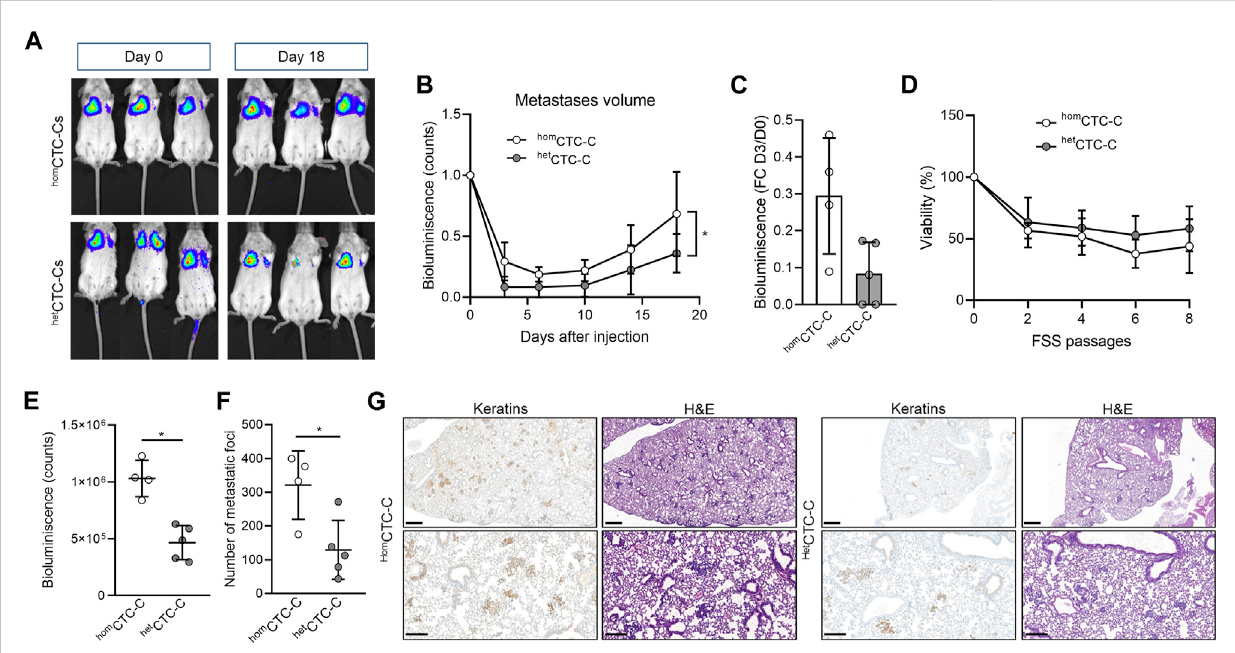
FIGURE 3 Assessing metastatic colonisation ability of hom CTC-C and het CTC-C inthemouse. (A) Representative imagesof thedevelopmentoflung metastatic lesions over time in mice injected into the lateral tail vein with hom CTC-C and het CTC-C assessed by measuring the bioluminescence signal (counts); (B) Bioluminescence signal throughout time emitted by the tumour cells that has colonised the pulmonary tissue (at least n = 4 mice per group); (C) Percentageofdecreaseofthebioluminescencesignalinthelungofmice3daysaftertailveininjectionof hom CTC-Cor het CTC-C; (D) Cellviabilityof hom CTC-Cand het CTC-Csubjectedtodifferentpassagesofhighmagnitude fl uidshearstress(FSS); (E) Quanti fi cationofthebioluminescencesignalinthe lungs at day 18; (F) Quanti fi cation of the number of metastatic foci in the lungs; (G) Representative images of lungs with metastases, visualized with Hematoxin-eosin (H&E), and sections of the lung stained with an antibody for keratins. Note the brown staining in tumour clusters and nodules. Images are shown at a ×3 magni fi cation (scale bar 500 μ m; upper images) and a ×10 magni fi cation (scale bar 200 μ m; lower images). * p <